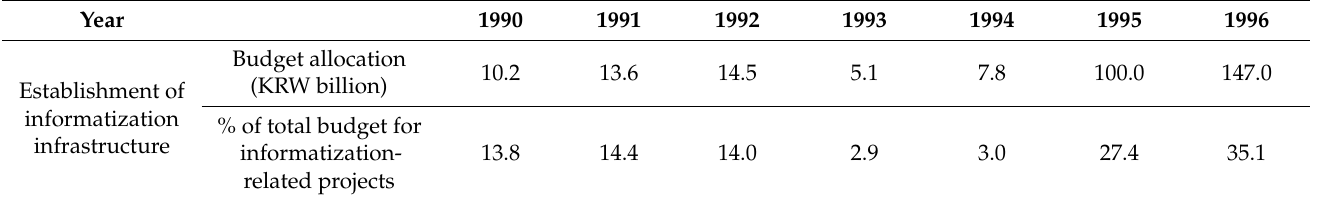
Table 4. The Government Budget for Informatization Projects